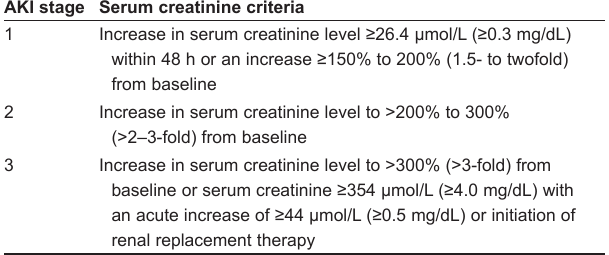
TABlE 1 Acute Kidney Injury Network classification of acute kidney injury (AKI) AKI stage Serum creatinine criteria